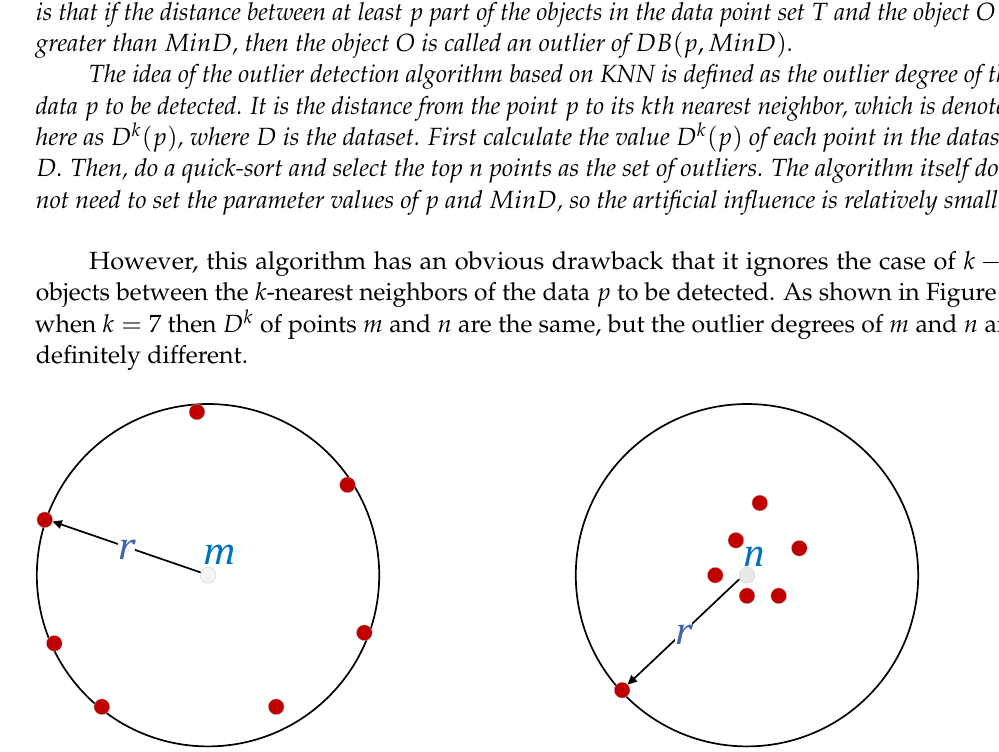
Figure 2. m and n have the same value, but different outlier